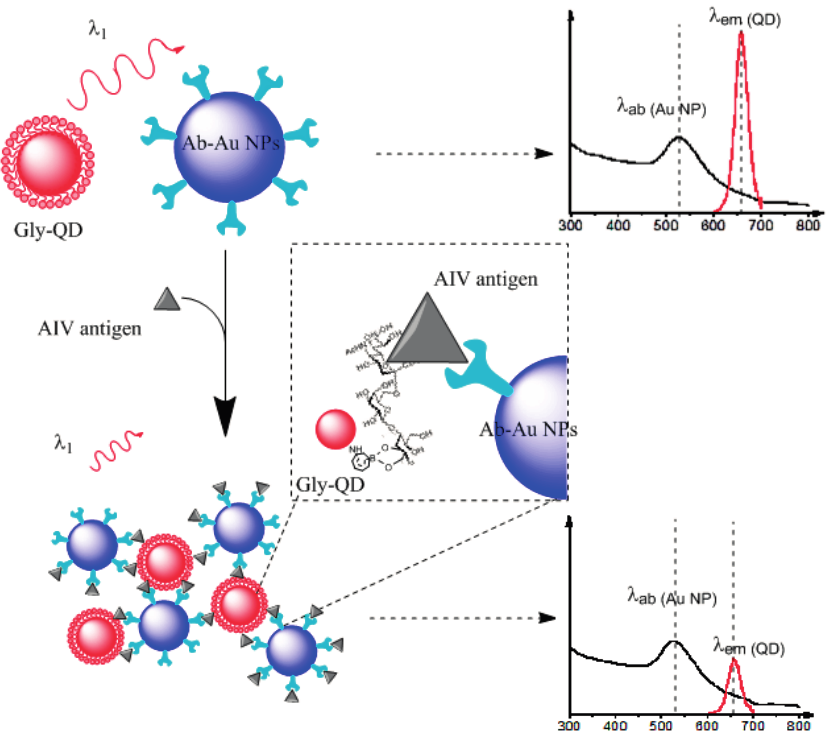
Figure 1. Schematic illustration of the assay architecture for sensing avian influenza virus (AIV) surface antigen